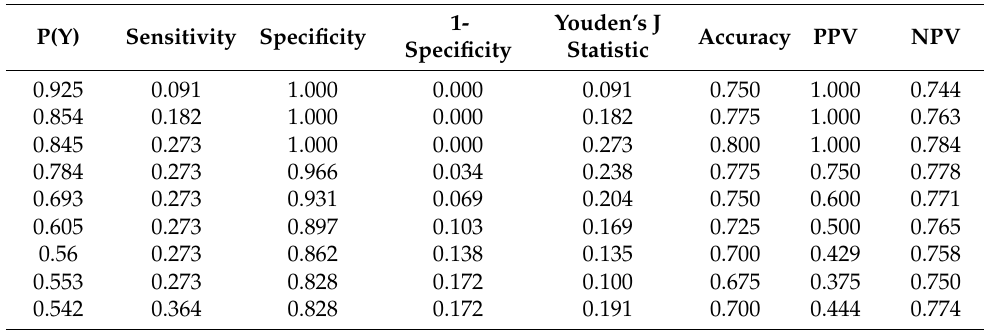
Table A4. Detailed information regarding selected prediction-related parameter values associated with the logistic regression model featured in this